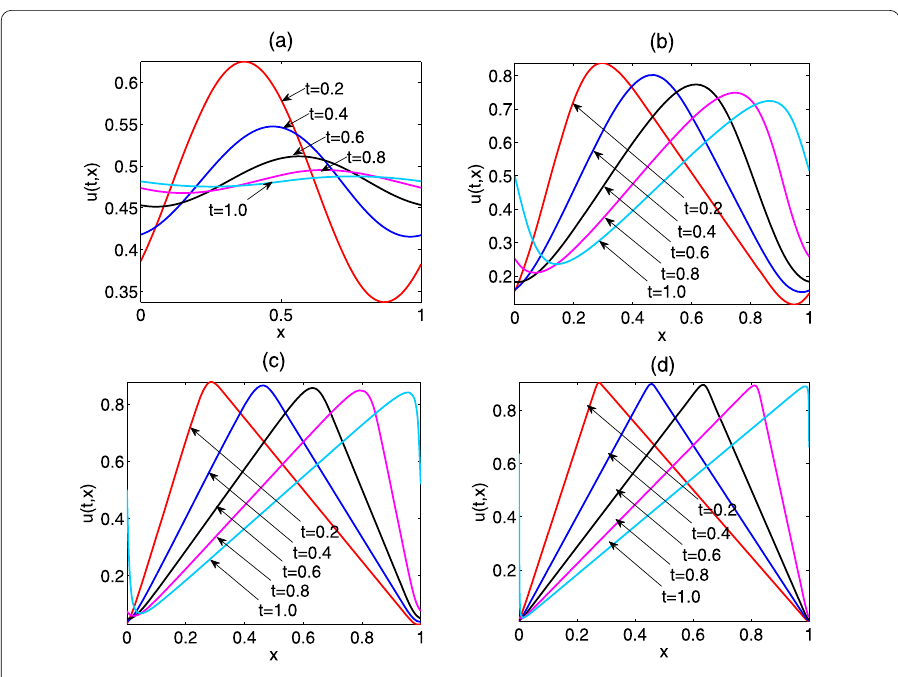
Figure 3 Numerical solutions of Example 1 on the periodic boundary with ( a ) ν = 10 –1 , ( b ) ν = 10 –2 , ( c ) ν = 10 –3 and ( d ) ν = 10